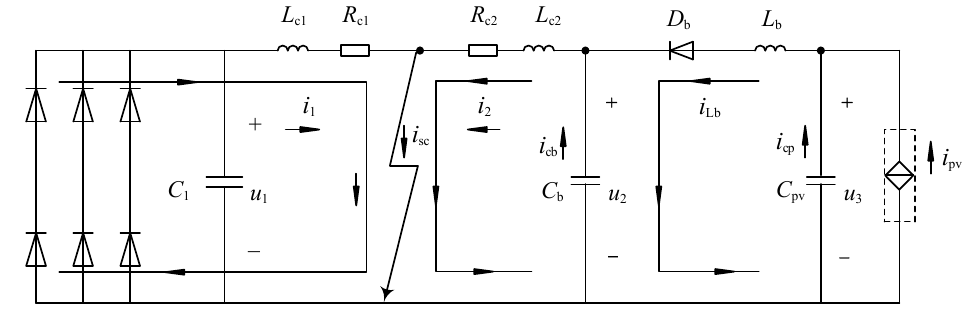
Figure 4. Equivalent circuits for the short-circuit fault at diode freewheel stage.